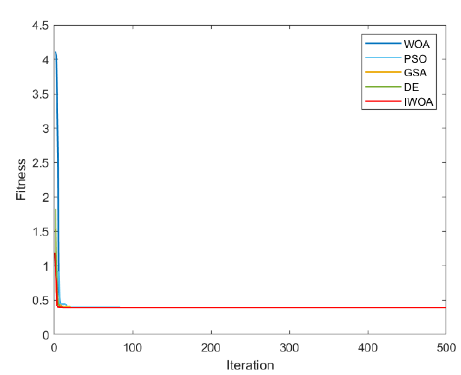
Figure 16. F11. Figure 16. F11.